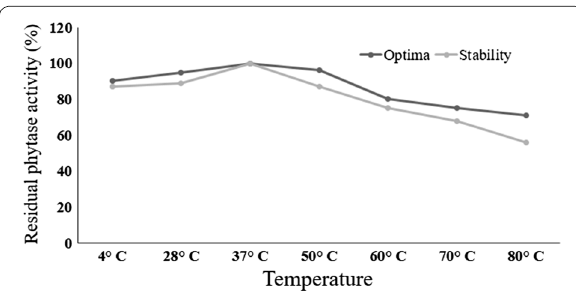
Fig. 2 Temperature optima and thermo-stability profiling of purified phytase from Aspergillus foetidus MTCC 11682. The 37 °C was found to be the temperature optima and the enzyme was stable for 30 min at temperature ranges between 4 and 60